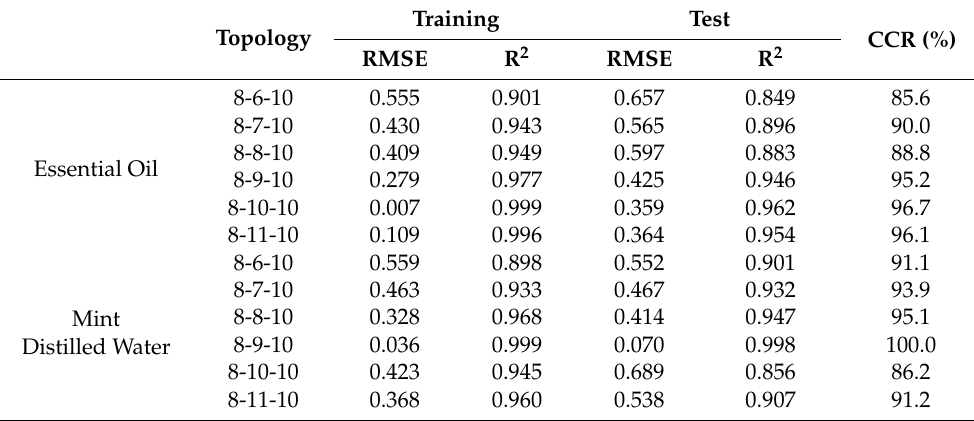
Table 5. Artificial neural network results.